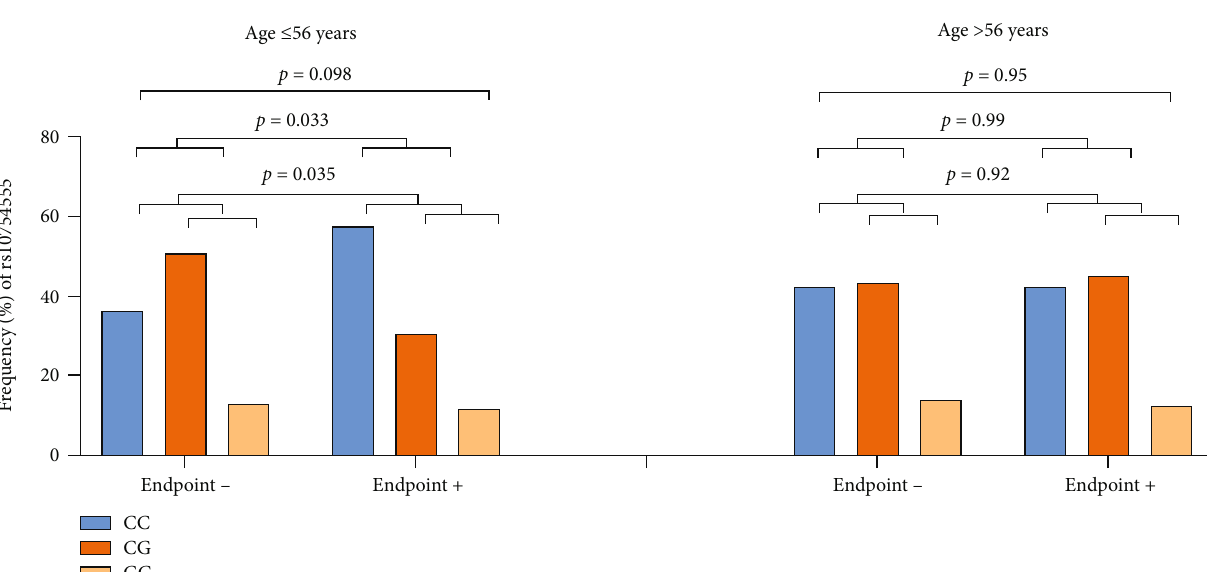
Figure 1: Frequency (%) of the NLRP3 (rs107545555 C/G) polymorphism according to clinical outcome dichotomized according to age at the 25 percentile level (56 years). Blue, orange, and pale orange columns represent homozygous wild type (CC), heterozygous (CG), and homozygous of the gene variant (GG), respectively. p values represent di ff erence in genotype frequencies according to endpoint (chi square test) between CC, CG, and GG genotypes ( 2 × 3 table) between CC and CG genotypes ( 2 × 2 table), and between the CC genotype and the G-allele (CG/GG combined) ( 2 × 2